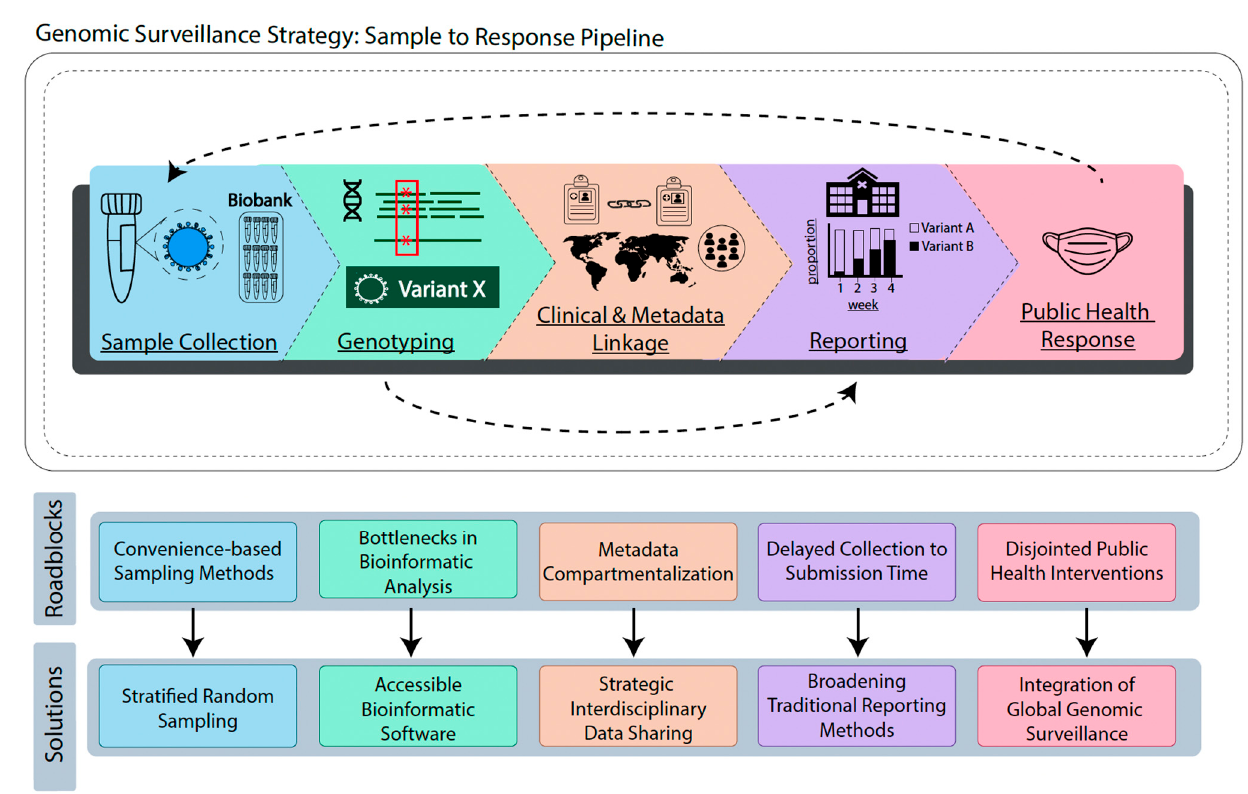
Figure 1. Molecular Surveillance Pipeline. The pipeline outlines the main concept of each process (sample collection, genotyping, clinical and metadata linkage, reporting, and public health response), and illustrates the solutions and roadblocks present at each stage of the pipeline. Asterisks in the genotyping section are representative of identified mutations in variant